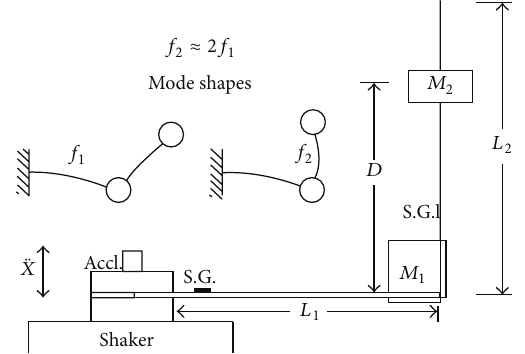
Figure 3: L-shape structure excitation, Balachandran and Nayfeh